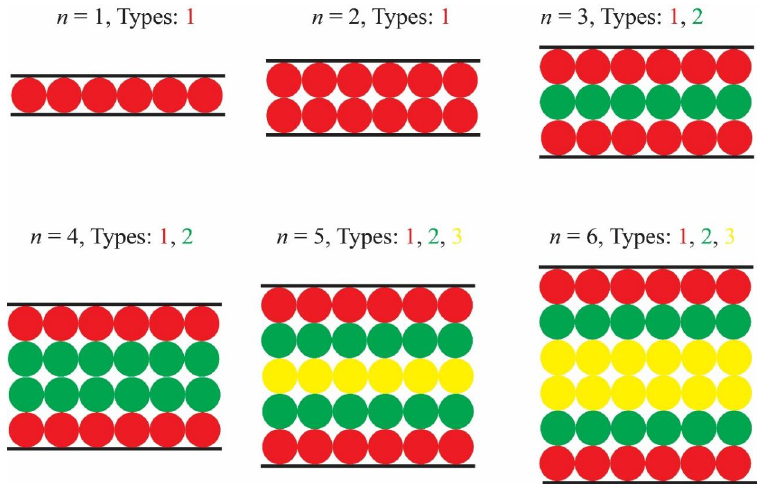
Figure 1. Schematic representation (side view) of distinct origins to be considered for the enumeration of self-avoiding random walks (SAWs) for systems under plate-like confinement. Black lines at the top and bottom parts mark the confining boundaries (plates). Level of confinement is quantified through the number of crystal layers between the plates, n , along the axis of confinement. Labeling according to SAW origin depends on the distance from the closest plate. Different color corresponds to different SAW origin (Type). Red, green and yellow colors correspond to Type 1 (closest to the plates), 2 and 3 (furthest from the plates).